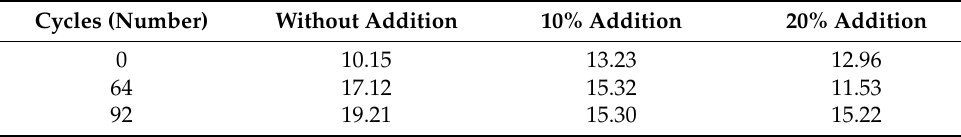
Table 4. Total porosity of mortars (%) exposed to gelifraction cycles. Cycles (Number) Without Addition 10%